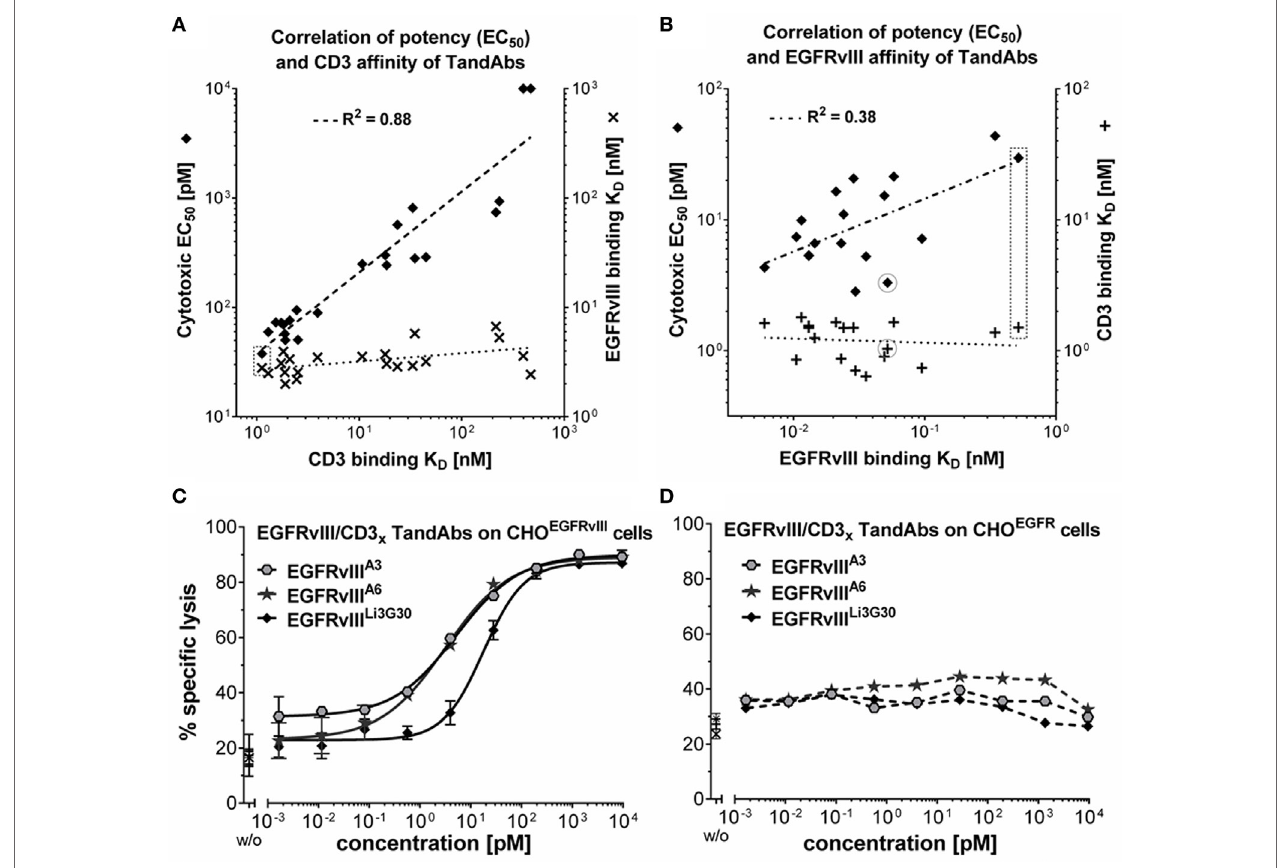
FigUre 4 | Target and effector affinity-dependent T-cell-mediated cytotoxicity of egFrviii/cD3 tandem diabodies (Tandabs) . (a) Illustration of the positive correlation of cytotoxic potency with CD3-binding affinities of EGFRvIII/CD3 TandAbs. More than 20 EGFRvIII/CD3 TandAbs all containing the identical EGFRvIII-binding domain (Li3G30) but different variants of CD3 x -binding domains with a range of affinities for CD3 were characterized. CD3 binding was analyzed on CD3 + -Jurkat cells, EGFRvIII binding on CHO EGFRvIII cells, and cytotoxic potency in killing assays. EGFRvIII-binding K D values ( x ) and cytotoxic EC 50 values ( ⬥ ) are plotted over the CD3-binding K D values for each of the analyzed TandAbs. Log values were analyzed by linear regression showing the correlation of cytotoxic EC 50 and CD3-binding K D indicated by a dashed line; goodness of fit is shown as R 2 value calculated with Graphpad Prism. (B) Illustration of the positive correlation of cytotoxic potency with EGFRvIII-binding affinities of EGFRvIII/CD3 TandAbs. 18 EGFRvIII/CD3 TandAbs all containing high-affinity human CD3-binding or human/ cynomolgus cross-reactive CD3-binding domains combined with EGFRvIII-binding domains having a range of different affinities for EGFRvIII were characterized. CD3 binding was analyzed on CD3 + -Jurkat cells, EGFRvIII-binding K D values were measured in SPR and cytotoxic potency in killing assays. CD3-binding K D values ( + ) and cytotoxic EC 50 values ( ⬥ ) are plotted over the EGFRvIII-binding K D values for each of the analyzed TandAbs. Log values were analyzed by linear regression showing the correlation of cytotoxic EC 50 and EGFRvIII-binding K D indicated by a dashed line; R 2 value was calculated using Graphpad Prism. Values of the EGFRvIII Li3G30 /CD3 x TandAb are marked with a dashed box, and values of the selected EGFRvIII A6 /CD3 x TandAb are circled. (c) Comparison of cytotoxic properties of EGFRvIII/CD3 TandAbs containing different anti-EGFRvIII domains A3, A6, or Li3G30 on CHO EGFRvIII . Lysis values obtained for a given antibody concentration were